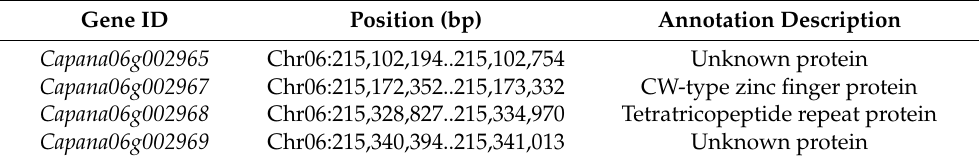
Table 4. List of four annotation genes in the mapping region of CaRf HZ